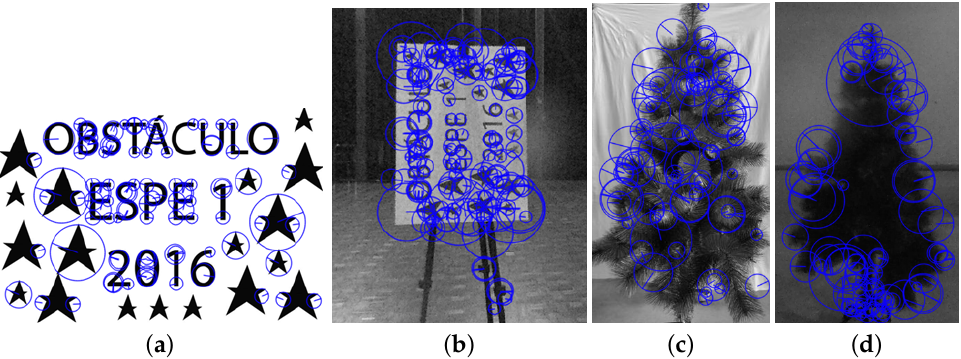
Figure 2. Feature point description. ( a ) Pre-designed obstacle, on the database; ( b ) Pre-designed obstacle, captured by the MAV; ( c ) Obstacle present in the environment, on the database; ( d ) Obstacle present in the environment, captured by the MAV.